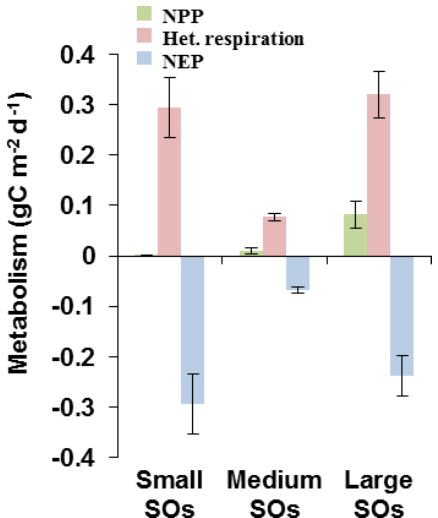
Figure 9. Metabolism for small, intermediate and large stream orders (SO) (here represented by SO1, SO5 and SO7, respec- tively) of the Seine basin simulated by pyNuts-Riverstrahler and averaged over the 2010–2013 period: net primary produc- tion (NPP, gCm 2 d − 1 ), heterotrophic respiration (het. respiration, gCm 2 d − 1 ), net ecosystem production (NEP, gCm 2 d − 1